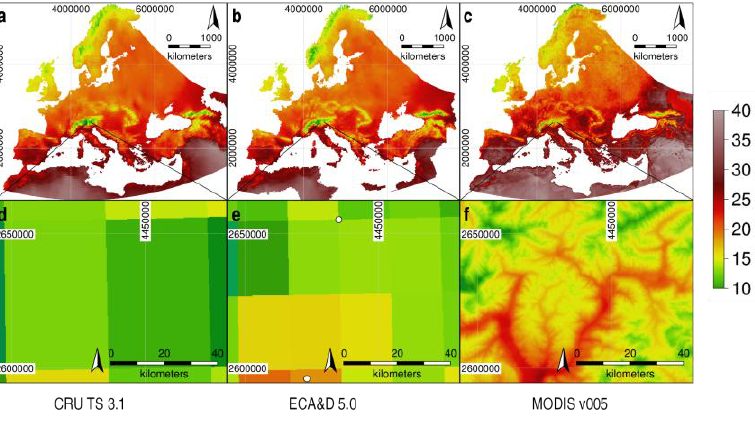
Figure 4. The heat wave hitting Europe in July 2003, in different seamless and gap-free temperature datasets. At the continental scale, the spatial pattern of ( a ) Climatic Research Unit (CRU ) , ( b ) European Climate Assessment and Dataset (ECA&D) and ( c ) reconstructed MODIS LST is comparable, even though the extreme heat in southern France is apparent only with MODIS LST (c). At the local scale, some hot areas cannot be detected with ( d ) CRU and ( e ) ECA&D, which are clearly visible with the higher spatial resolution of ( f ) reconstructed MODIS LST. The two white points in (e) are the meteorological stations used by ECA&D in the area. All data are in the Lambert azimuthal equal area projection (EPSG code: 3035). The extents in geographical degrees of (d), (e)